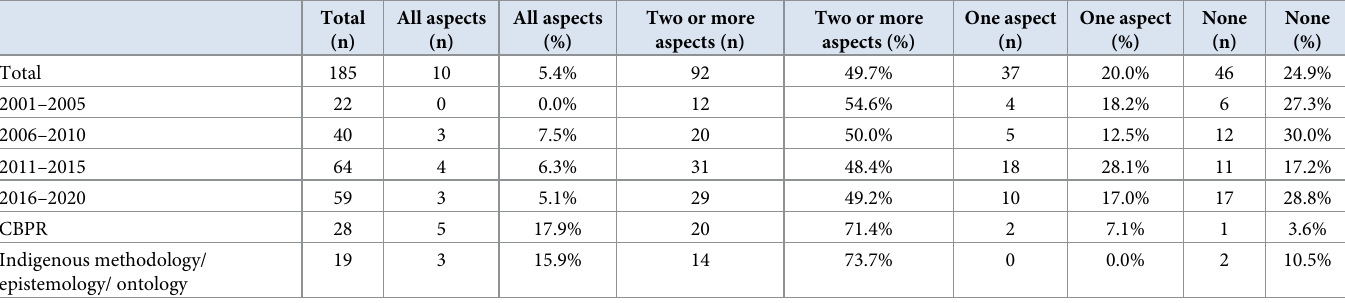
Table 2. Empirical articles that report engagement with community in various aspects of the research